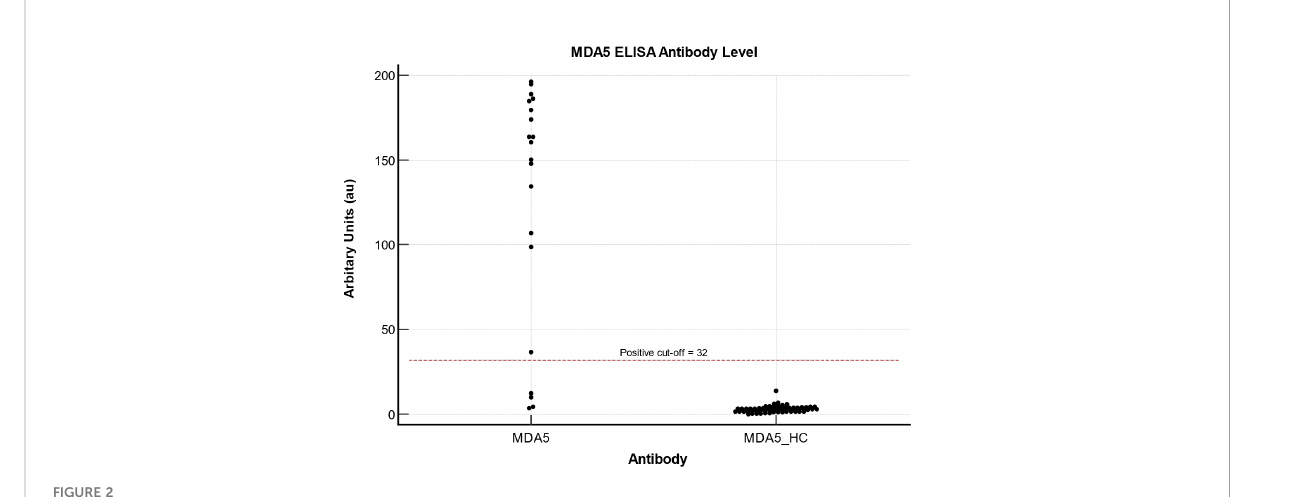
FIGURE 2 MDA5 ELISA values for 20 MDA5 and 62 healthy control samples.